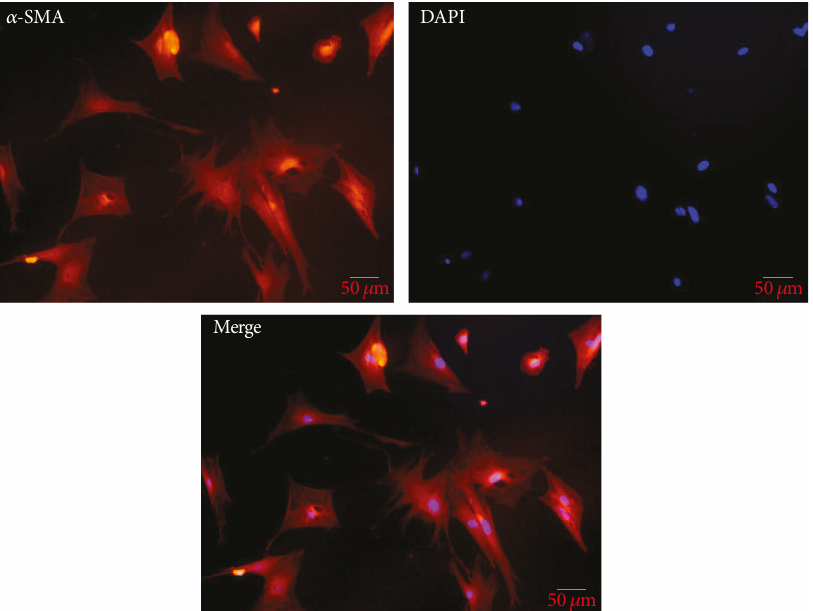
Figure 1: A random view of immuno fl uorescence visualization of α -SMA, a marker for ISCs, was performed. All of the ISCs were α -SMA- positive